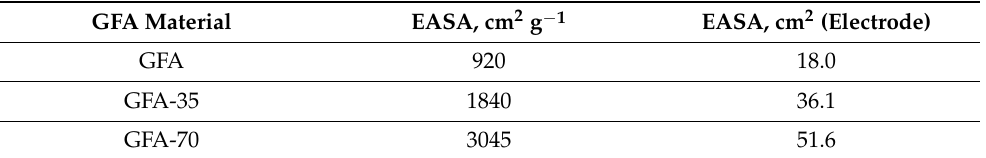
Table 6. Parameters characterizing GFA materials applied in recording cyclic voltammograms in the solution of 1 mM 4-chlorophenol (0.05 M Na 2 SO 4 ) and presented in Figures 7 and 8.